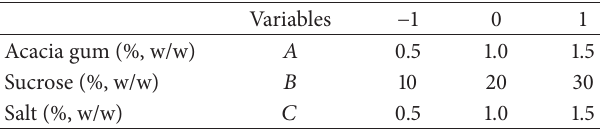
Table 1: Experimental ranges and levels of independent variables used in RSM in terms of actual and coded